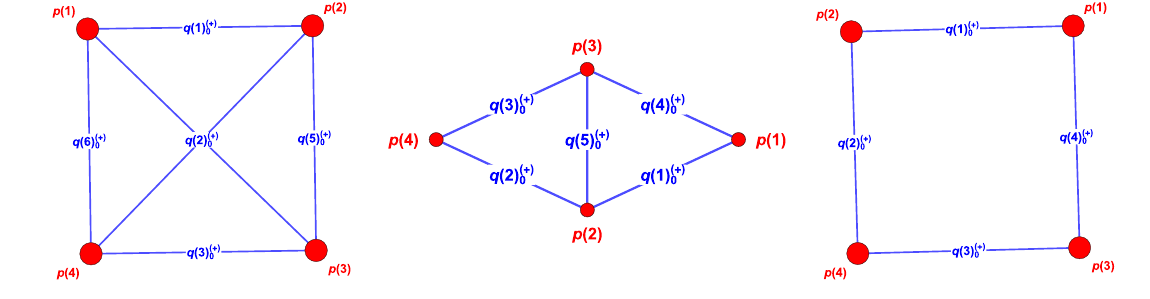
Fig. 4 Loop topologies with four cusps generated with PlotTop